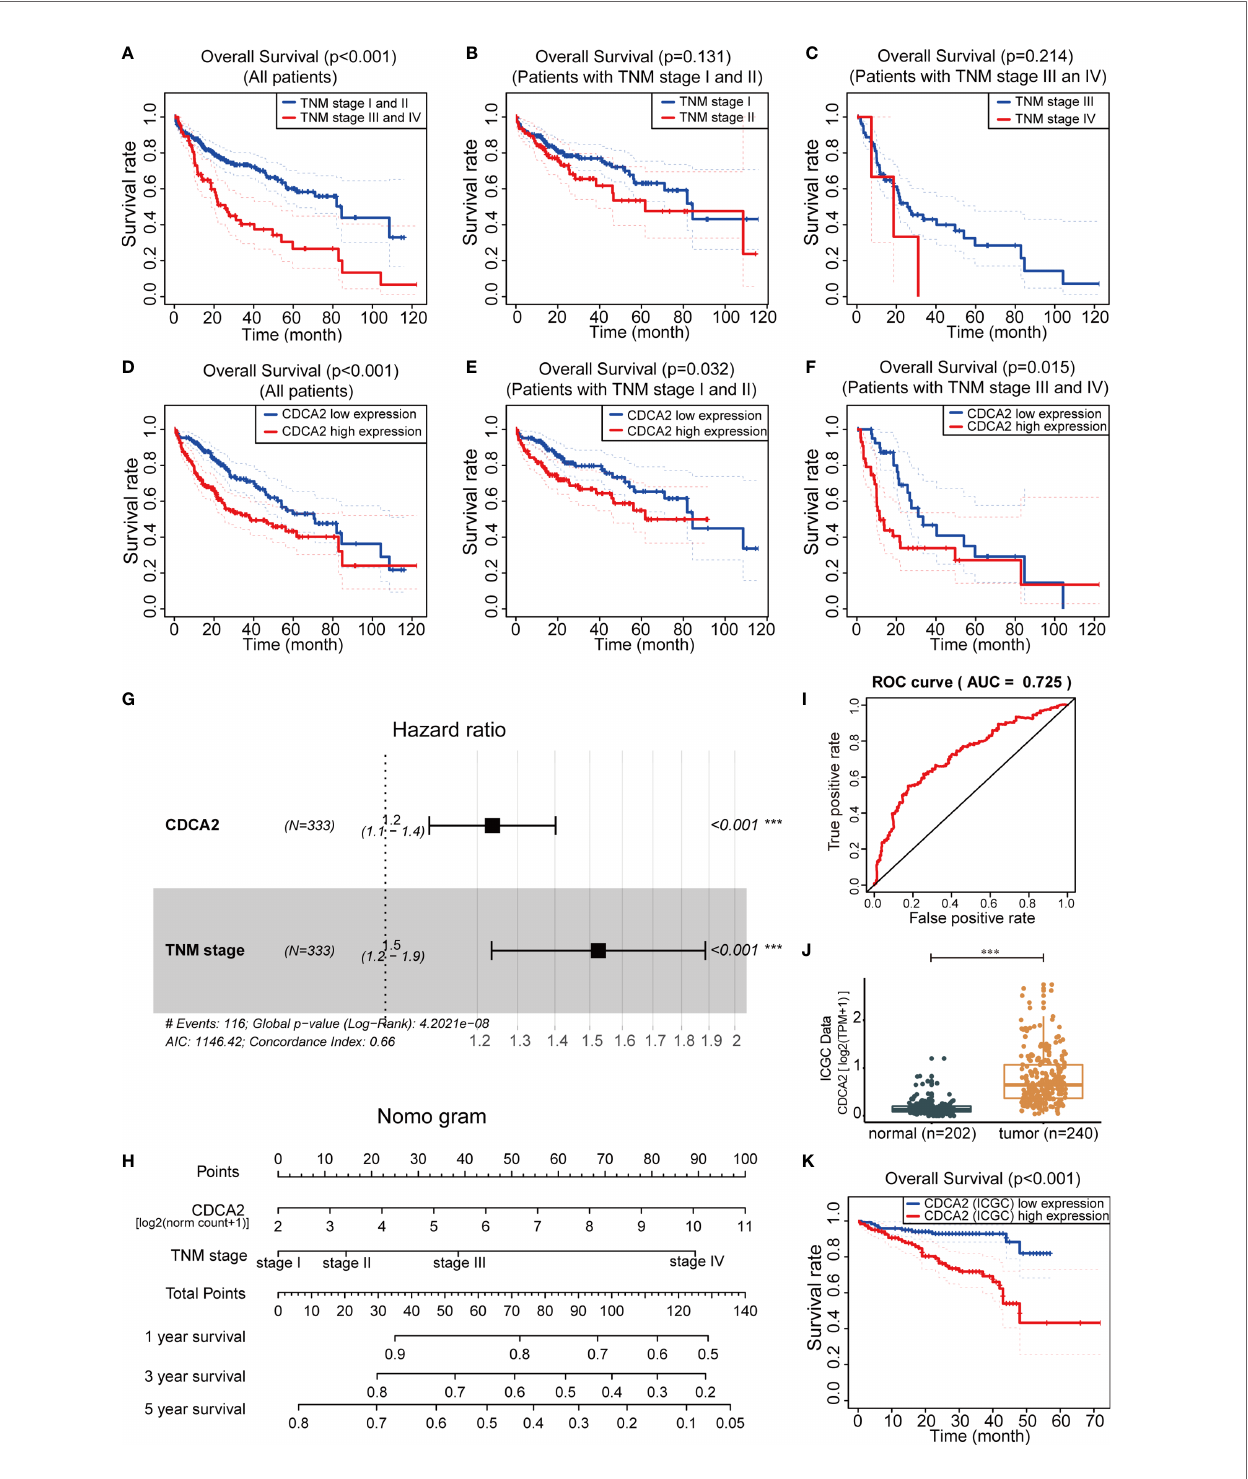
FIGURE 5 | Cell division cycle associated 2 (CDCA2) was associated with hepatocellular carcinoma (HCC) prognosis. (A – F) In The Cancer Genome Atlas (TCGA) cases, the impact of TNM stage and CDCA2 on the prognosis of all HCC cases, early HCC cases (TNM stage I/II), and mid- to late-stage HCC cases (TNM stage III/ IV) was analyzed by Kaplan-Meier (KM) survival. (G) Forest plot illustrated the hazard ratio (HR) values of CDCA2 and TNM stage by multivariate Cox regression analysis. (H) The nomogram of prognostic 1-, 3-, and 5-year survival rates for HCC was constructed based on CDCA2 expression values [log2 (norm count + 1)] and TNM stage. (I) Receiver operating characteristic (ROC) curve analysis of predictive ef fi cacy of the nomogram model. (J, K) Comparison of mRNA levels and survival analysis of CDCA2 in HCC and paraneoplastic samples originating from Japan in International Cancer Genome Consortium (ICGC) database. ***p <